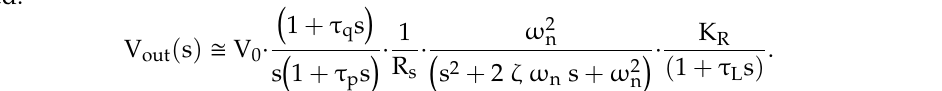
Figure 5. Comparison between the waveforms V out (t) obtained from Equations (9) (complete model) and (11) (approximate model). The inset shows the early part of the transient response. The inset in Figure 5 proves that the approximation of V out (t) and the complete model fit almost perfectly in the region of interest for time pickoff, with only marginal deviations. The two expressions start to diverge only in proximity of the peak of the exact model. It is worth noting that good fittings are obtained regardless of any realistic choice of the parameter values.